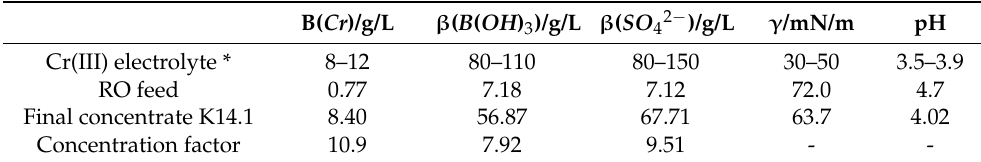
Table 1. Concentrations of main inorganic components, surface tension and pH value of the Cr(III) electrolyte, RO feed, as well as the final RO concentrate and concentration factors of the monitored substances in that concentrate.